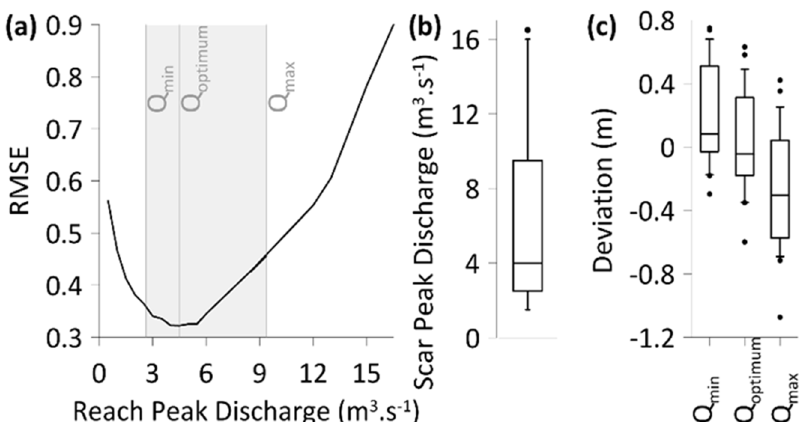
Figure 6. Parameters of the 2014 modelled flood discharge: ( a ) RMSE curve for the reach peak discharges where three scenarios are visualized with the uncertainty defined by Q min and Q max (filled rectangle); ( b ) the box plot of scar peak discharges; ( c ) the box plots of deviation between the measured PSI elevation and simulated water level. Whiskers in ( b ) and ( c ) are equal to the 10th and 90th percentiles ( n = 26).